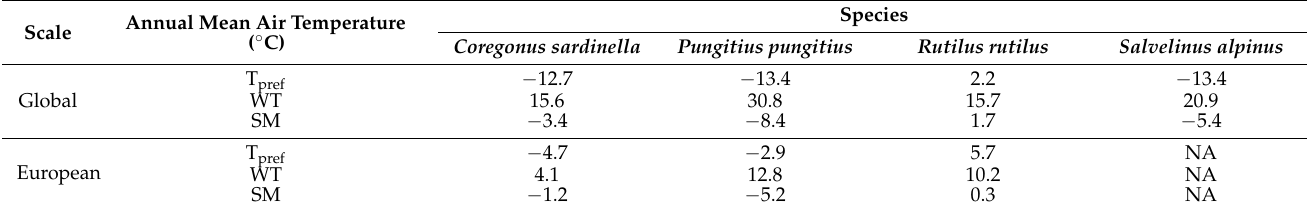
Table 2. Different thermal properties of the analyzed species for the two considered spatial extents. Species Scale Annual Mean Air Temperature ( ◦ C) Coregonus sardinella Rutilus